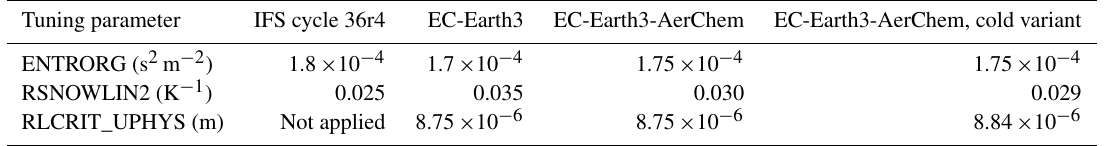
Table 8. Parameter settings for the three IFS parameters that have been readjusted for tuning the model’s preindustrial climate. The column labeled “EC-Earth3-AerChem” contains the values adopted in the CMIP6 configuration of the model, which correspond to a target reduction in the global mean surface temperature of 0.5 ◦ C compared with the configuration with the standard EC-Earth3 settings. The settings indicated in the column labeled “EC-Earth3-AerChem, cold variant” correspond to a target surface cooling of 0.75 ◦